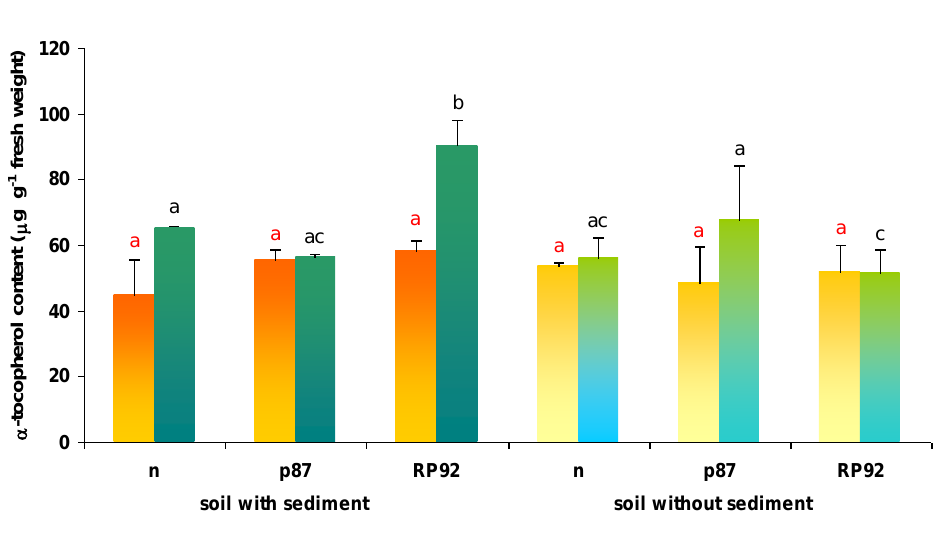
Figure 7. α -tocopherol content of the leaves of T. patula and F. arundinacea grown on control soil and soil amended with bottom sediments, with or without (n) inoculation with bacterial strain p87 or RP92. The same letters denote groups that did not significantly differ (at p < 0.05; the Duncan post hoc test). Statistical significance was measured for each plant separately and the results were marked by different colors.